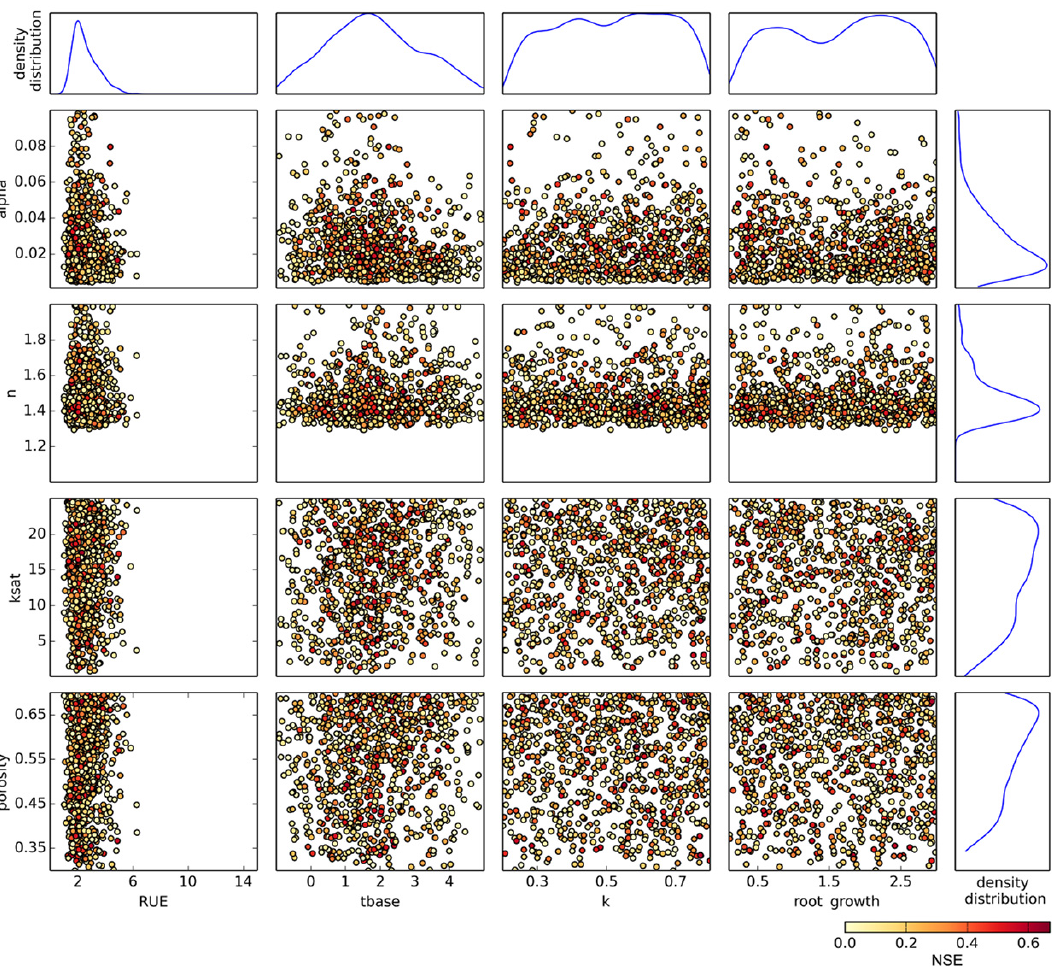
Fig. 1. Parameter uncertainty and interaction. The scatter plots show parameter interaction and correlations for behavioural model runs coloured from yellow to red for NSE > 0 at site 1 in Müncheberg for the coupled CMF–PMF model. PMF parameters are given on the x axis, and CMF parameters are plotted on the y axis. The density distributions at the top and to the right depict the parameter uncertainty. NSE are reported as mean, equally weighted NSE for soil moisture, root, stem and leaves, as well as storage dry